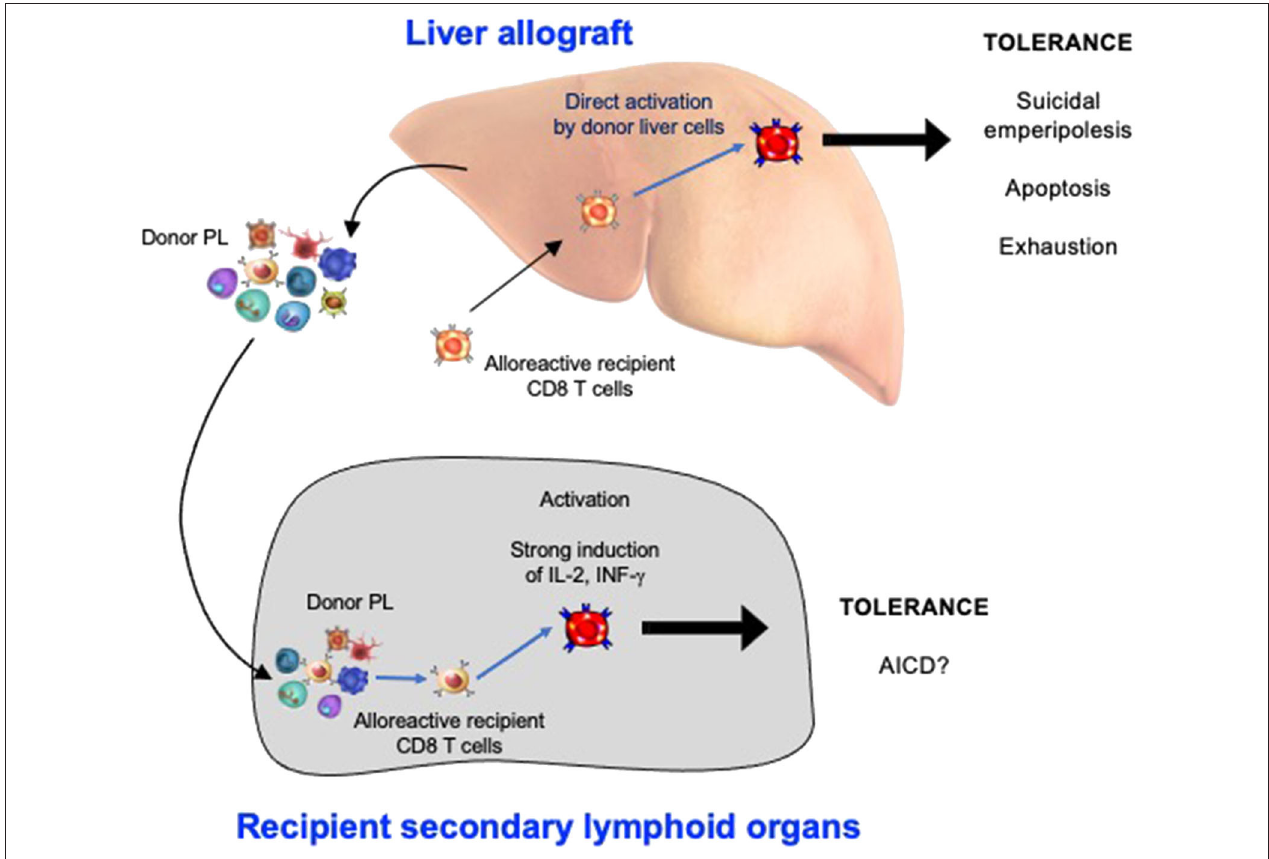
FIGURE 1 | The Induction phase of liver transplant tolerance: pathways of alloreactive CD8T cell silencing in recipient secondary lymphoid organs and within the hepatic allograft. PL, passenger leukocytes; AICD, activation induced cell death.